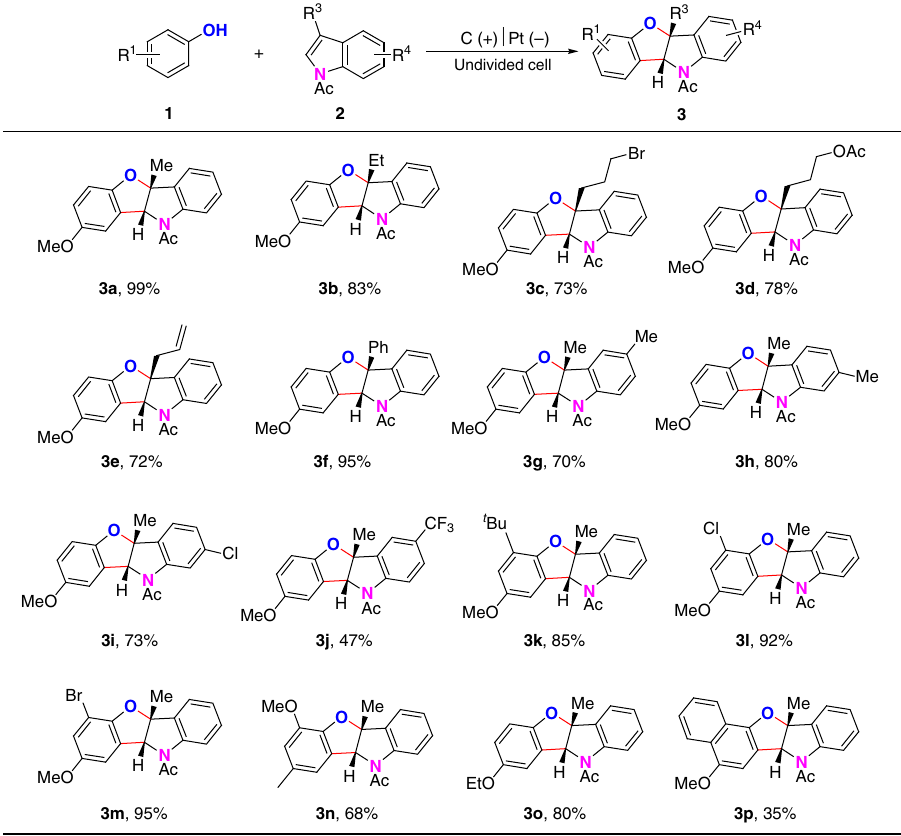
Fig. 2 Synthesis of benzofuro[3,2-b]indolines from 3-substituted N -acetylindoles. Reaction conditions: graphite rod anode ( ϕ 6 mm), platinum plate cathode (15 mm × 15 mm × 0.3 mm), constant current = 10 mA ( J ≈ 16.7 mA/cm 2 ), 1 (0.20 mmol), 2 (0.30 mmol), n Bu 4 NBF 4 (0.20 mmol), HFIP/CH 2 Cl 2 (6.0 ml/4.0 ml), room temperature, N 2 , 1.8 h (3.4 F). Isolated yields are